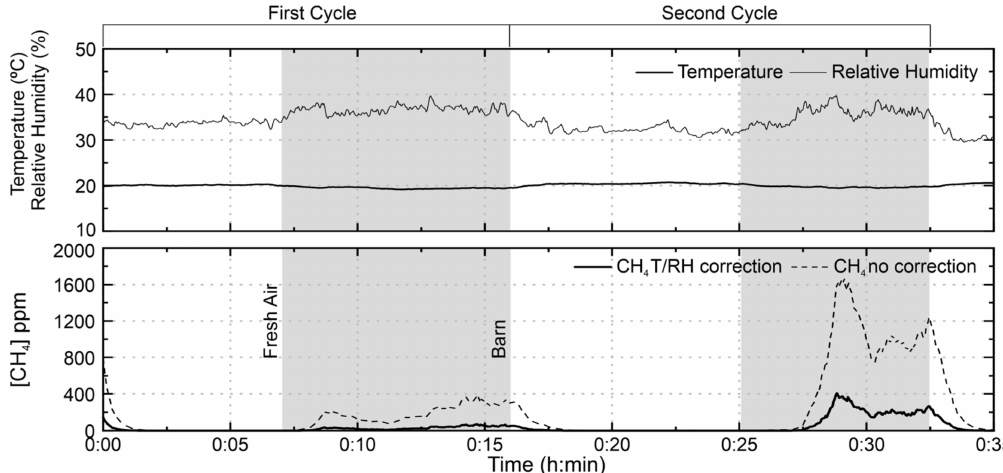
Figure 10. TGS2600 test on 20 April 2017 in the small ruminant barn of the Higher School of Agriculture of the Polytechnic Institute of Bragança. The test was performed in two cycles, each integrating measurements outdoors and inside the barn without animals. The shaded area corresponds to the sensor inside the barn, while the white area corresponds to the outdoor atmosphere (fresh